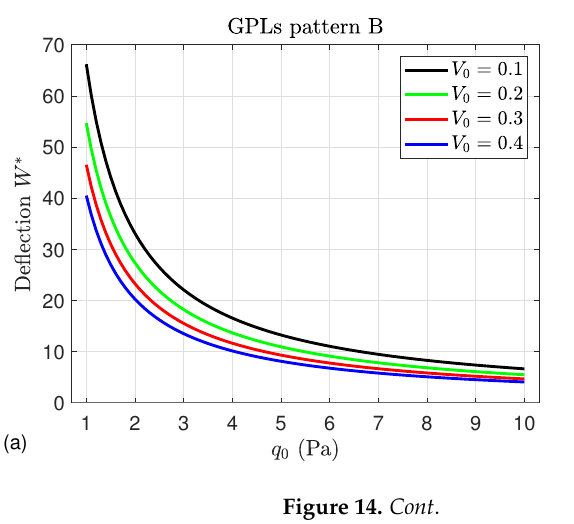
and ( d ) the in-plane shear stress σ ∗ 13